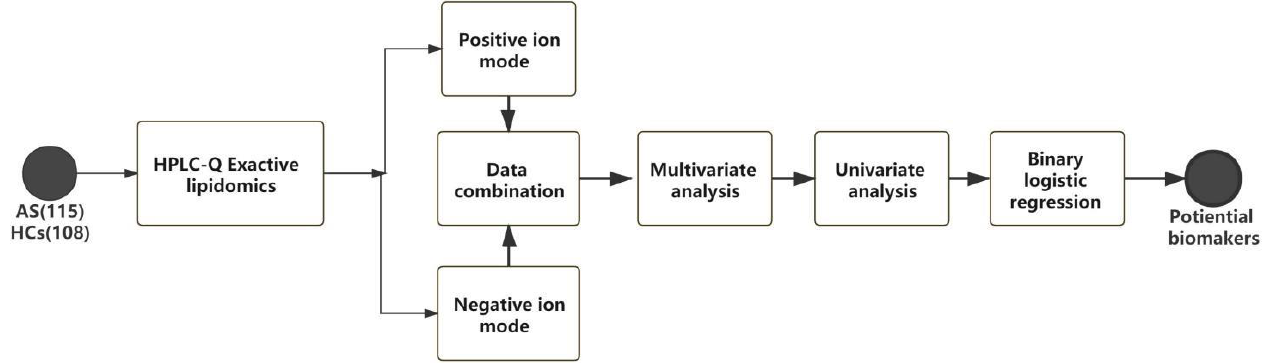
Figure 1. Design of this